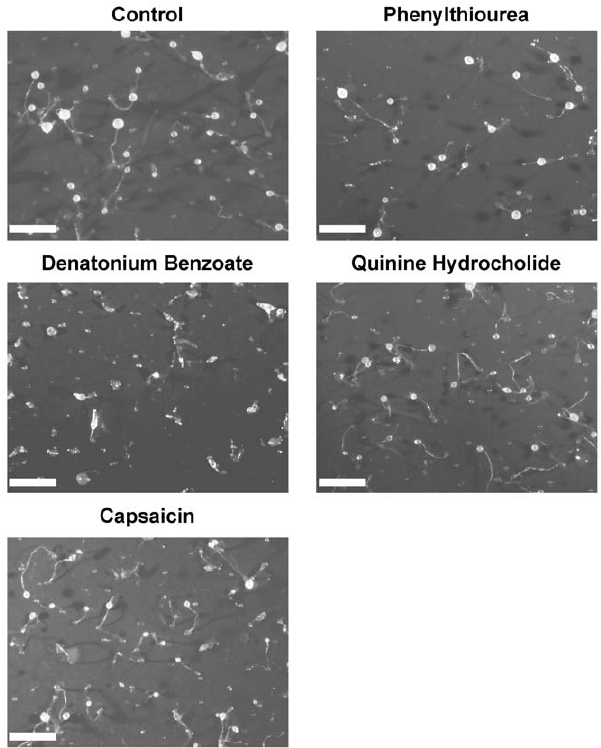
Figure 8. Analysis of tastants on Dictyostelium development. Cells were allowed to develop over 24 hours in the presence of control conditions, 3 mM phenylthiourea, 1 mM denatonium benzoate, 350 m M quinine hydrochloride and 100 m M capsaicin. All images are represen- tative of triplicate experiments indicating cell survival after 24-hours exposure to each compound. Scale bar represents 1